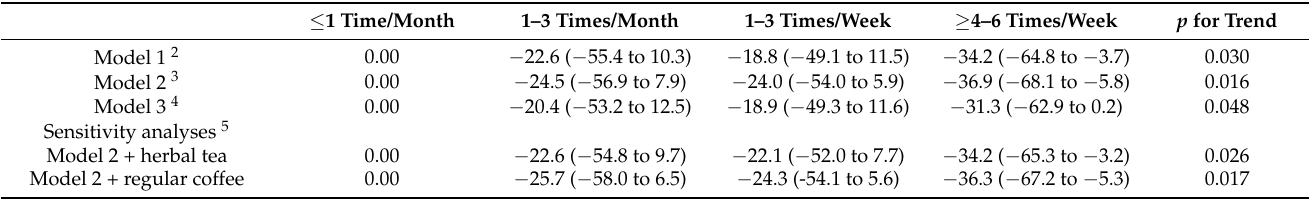
Table 2. Association ( β 95% CI) between nuts consumption and cognitive function (mean reaction time) among adults attending Qatar Biobank Study (n = 1000) 1